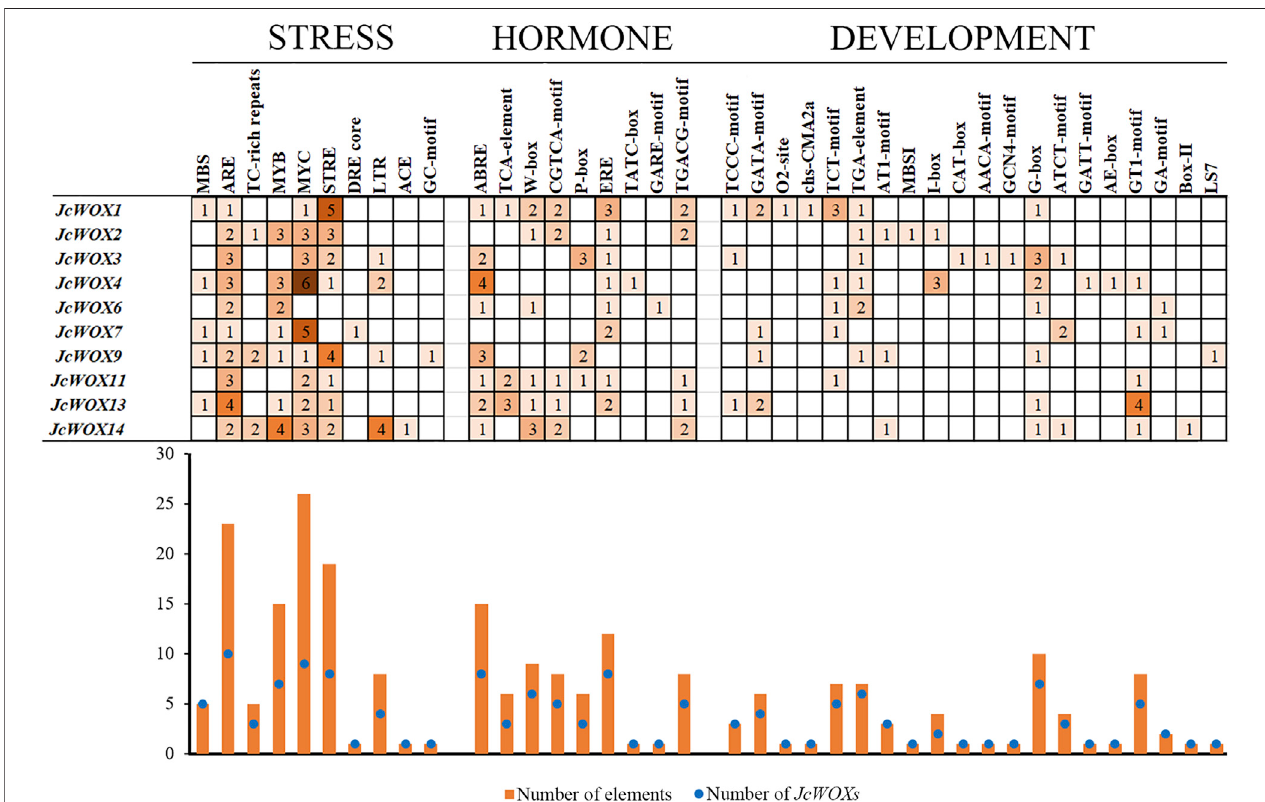
FIGURE 4 | Cis -acting elements in the promoter regions of 10 JcWOX genes. The number of cis -acting elements related to stress was the largest.